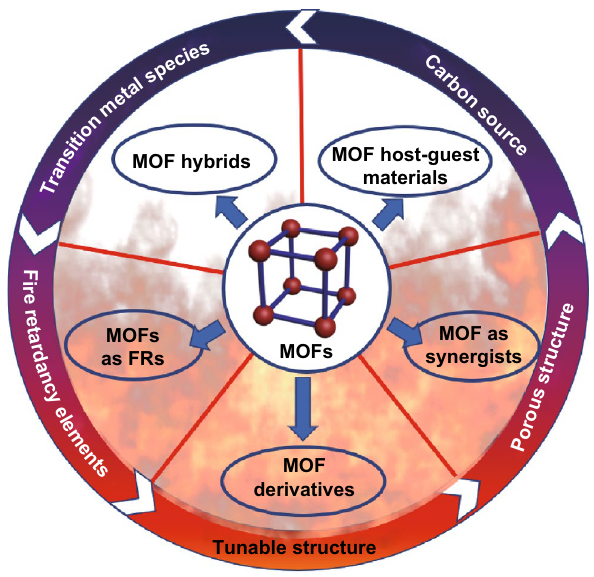
Fig. 2 Schematic illustration of the potential advantages of MOF as FRs and a variety of methods for preparing MOF‑based FRs